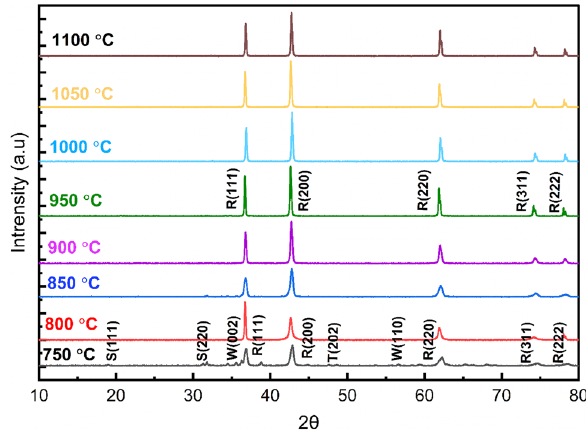
Fig. 4 XRD patterns for the entropy-stabilized oxide of an equimo- lar mixture of MgO, CoO, NiO, CuO, and ZnO. The patterns were col- lected from the powder form of a mixture, calcined at the tempera- ture in the range of 750 °C–1100 °C with 50 °C increments: Rock-salt (R), Wurtzite (W), Tenorite (T), and Co